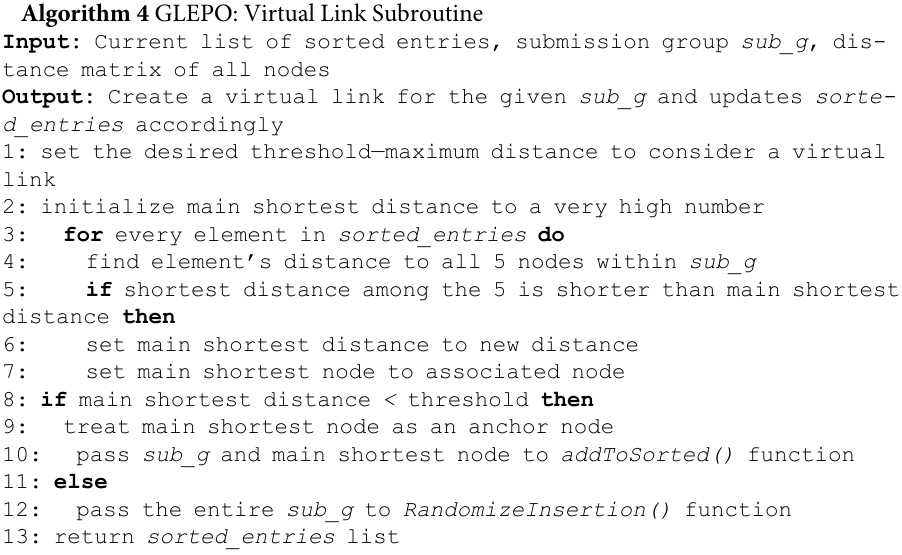
Algorithm 4 GLEPO: Virtual Link Subroutine